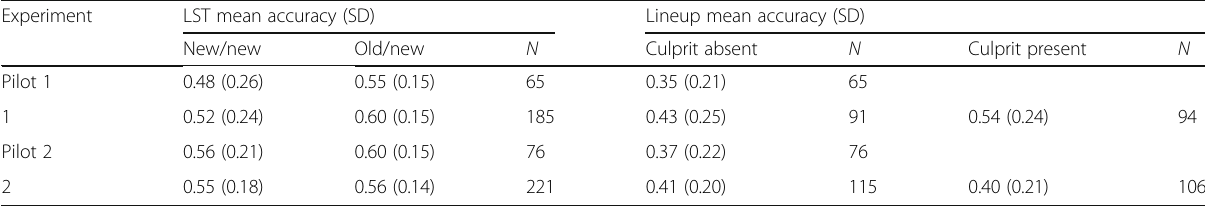
Table 3 Descriptive statistics of LST and lineup accuracy